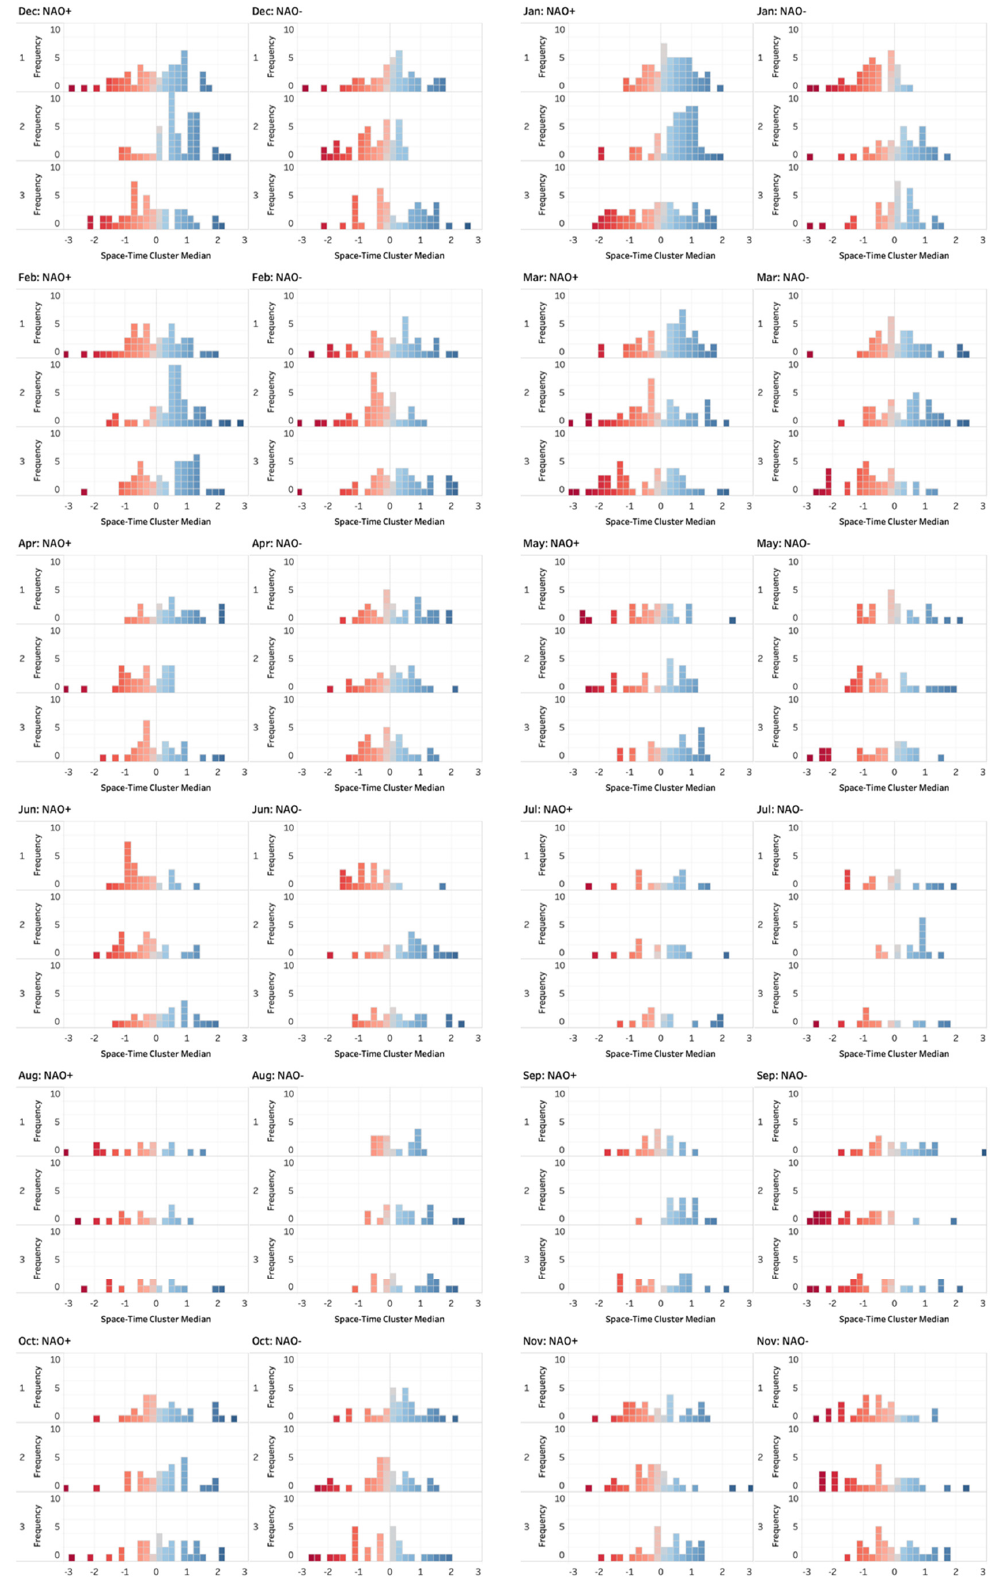
Figure 11. Frequency histograms of median SPI-1 values for the space–time clusters mapped in Figures 7 and 8.